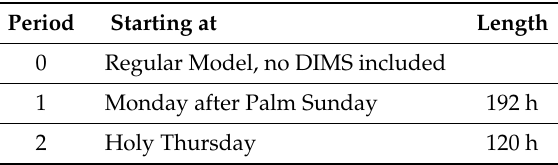
Table 4. Periods analysis